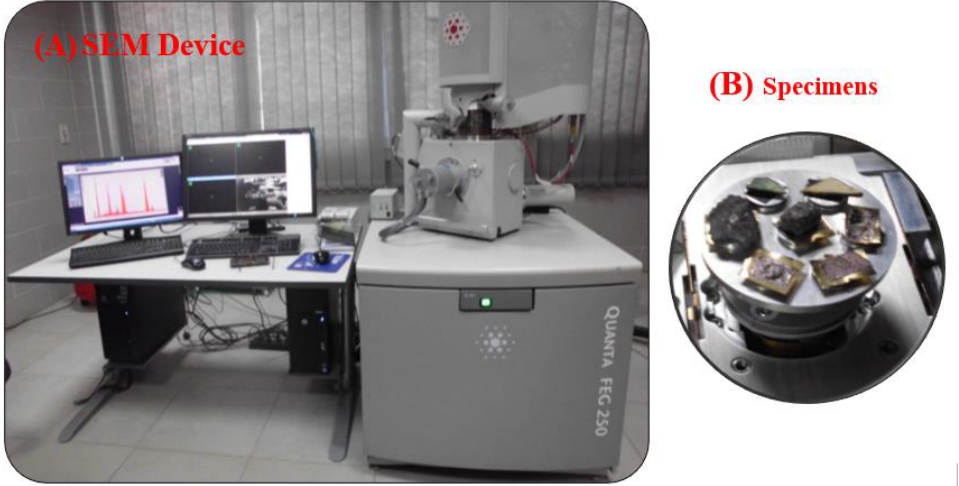
Figure 5. The view of ( A ) scanning electron microscopy (SEM) device; ( B ) specimens.